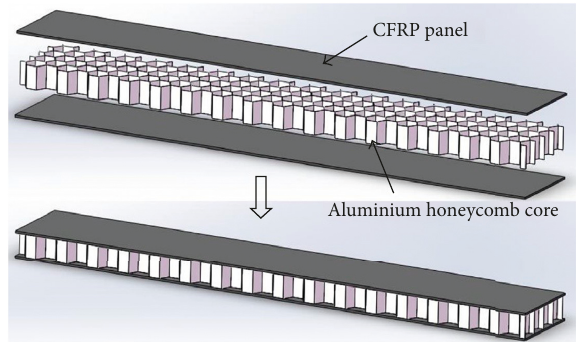
Figure 1: CAD model of sandwich panels with aluminium hon- eycomb core and CFRP